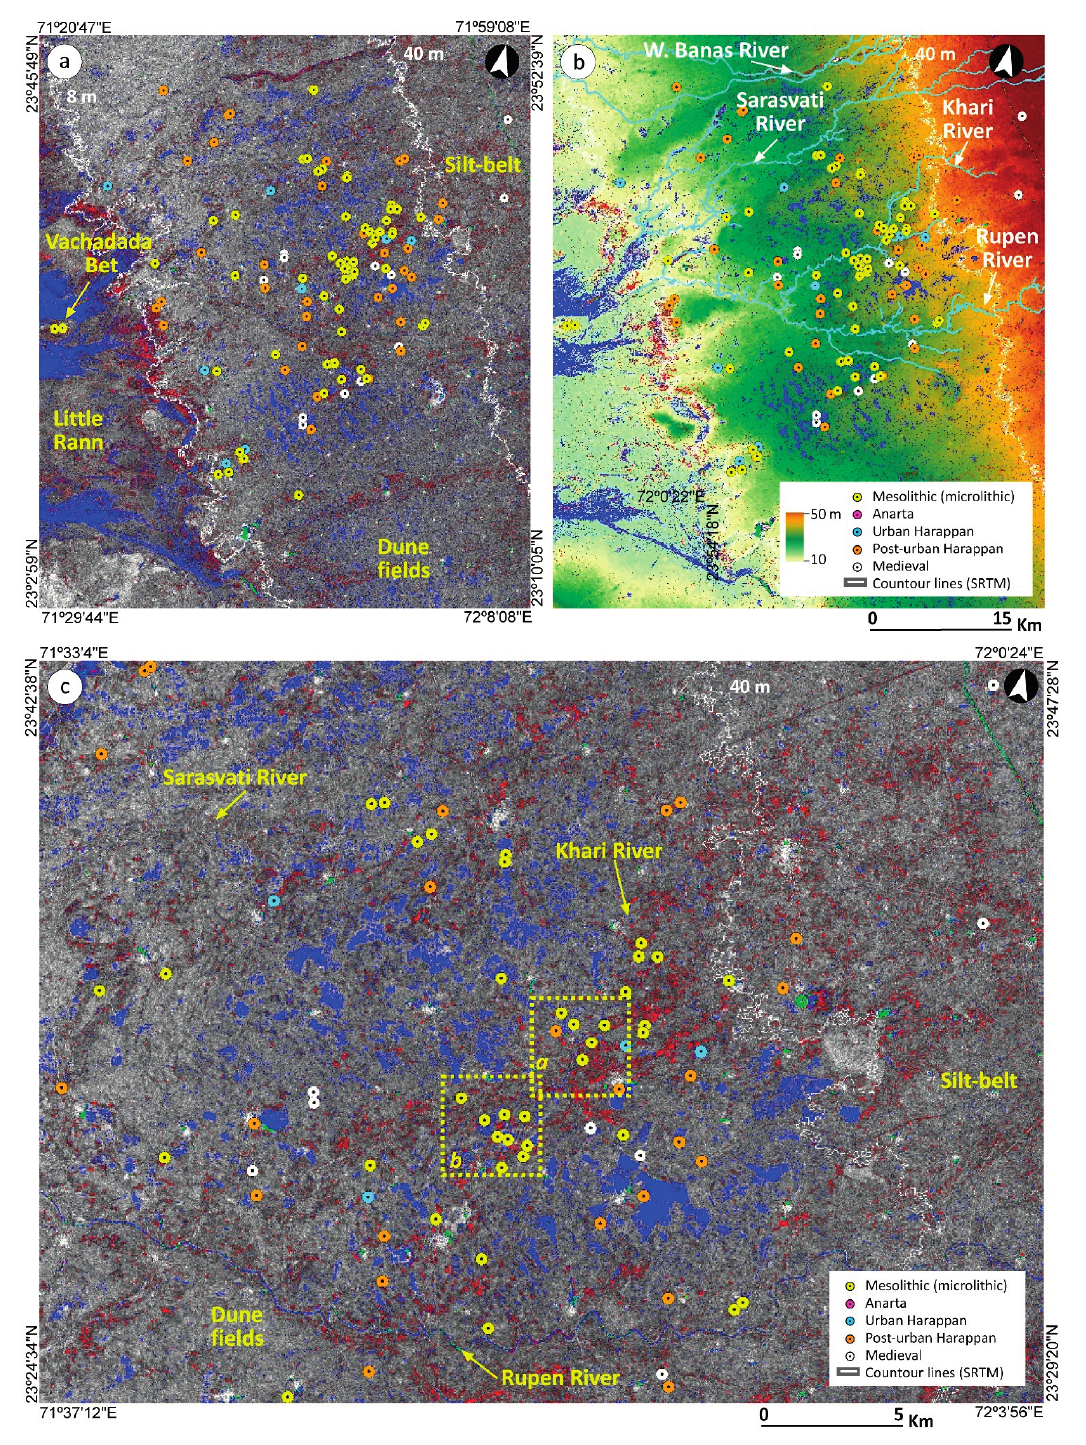
Figure 9. ( a ) Georeferenced seasonal flooding map (blue for monsoon, red for post-monsoon and green for no change) and regional distribution of archaeological sites; ( b) Integrated seasonal flooding map superimposed to regional elevation (SRTM 90 v4.1, http://srtm.csi.cgiar.org); ( c ) Integrated seasonal flooding map superimposed to the MA image for the Dune fields/Silt-b e lt (DS) subset of interest (dotted areas indicates the extent of Figure